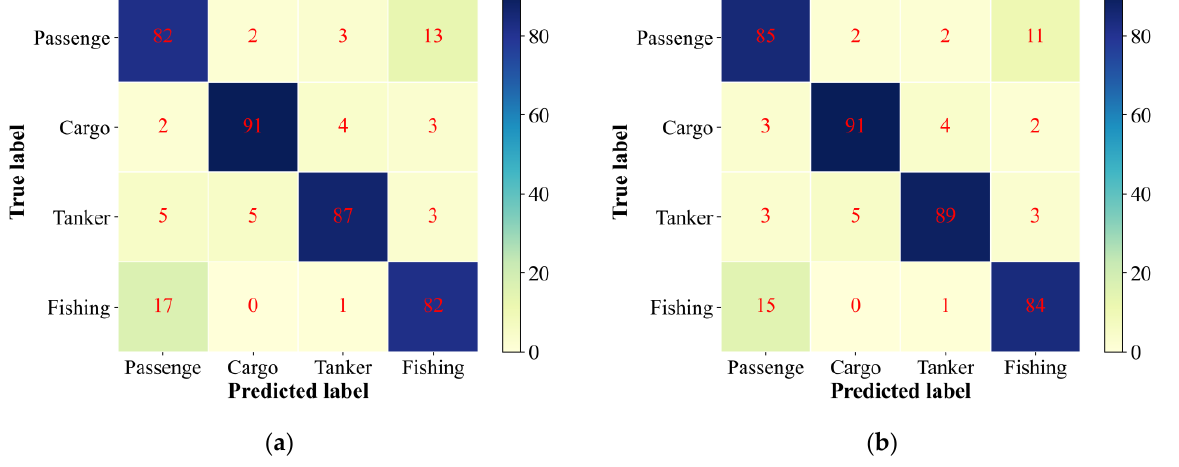
Figure 10. Confusion matrix of the MCEL model trained with different features on the AIS test set. ( a ) Confusion matrix using the SGFs and ( b ) confusion matrix using the NGFs.